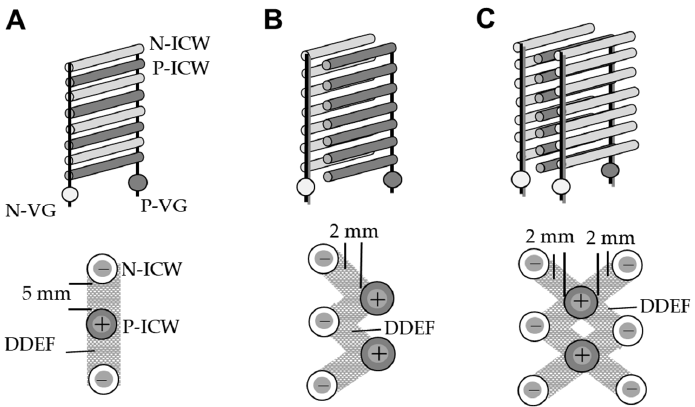
Figure 14. Single ‐ (1L) ( A ), two ‐ (2L) ( B ) and three ‐ layered (3L) ( C ) DD screens (upper) and double ‐ charged dipolar EFs (DDEFs) produced by oppositely charged insulated iron wires in each DD screen (lower). N ‐ VG, negative voltage generator; P ‐ VG, positive voltage generator; N ‐ ICW, negatively charged insulated conductor wire; P ‐ ICW, positively charged insulated conductor wire; DDEF, double ‐ charged dipolar electric field.